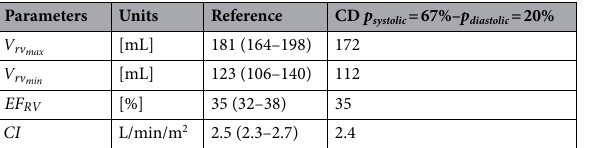
Table 2. Comparison of the CD condition outputs with in vivo reference data (mean and range) from Browning et al. 30 .